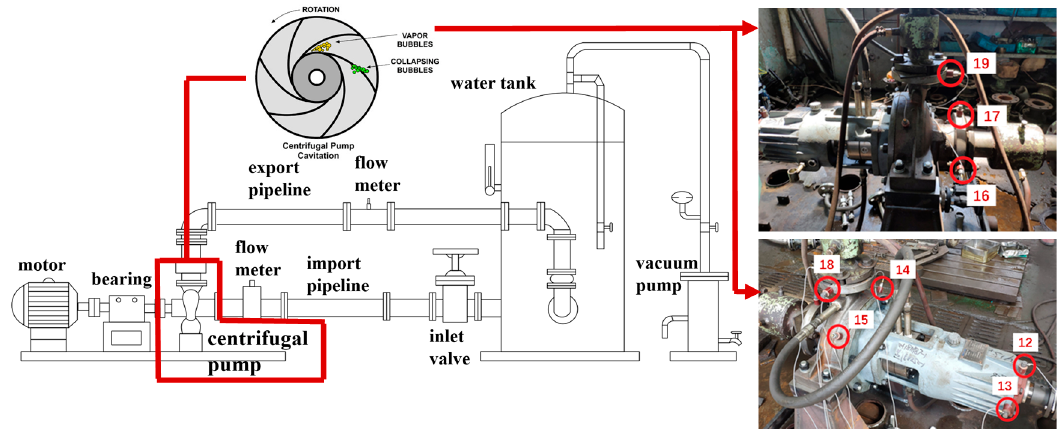
Figure 6. Configuration of a pump-valve test platform and the installation of eight accelerometers. In the middle part, the cavitation picture is taken from [37]. In the right part, the red circles (or ellipses) represent the accelerometers, and the number, such as 15, beside the circle is the accelerometer ID. The instruments from left to right are as follows: Motor, bearing, centrifugal pump, flowmeter, import pipeline, inlet valve, export pipeline, flowmeter, water tank, and vacuum pump.